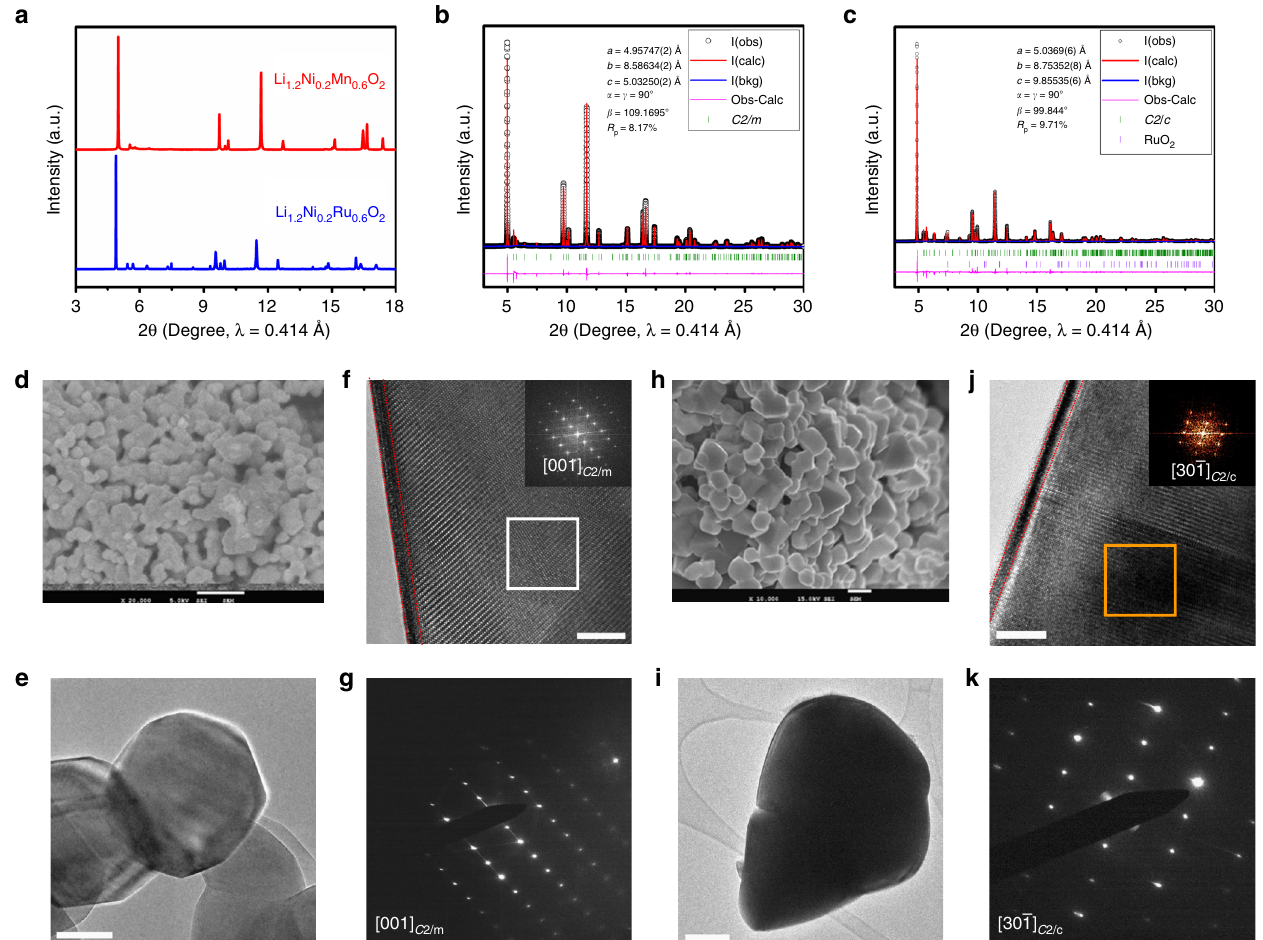
Fig. 1 Structural characterization of pristine Li 1.2 Ni 0.2 Mn 0.6 O 2 (LNMO) and Li 1.2 Ni 0.2 Ru 0.6 O 2 (LNRO). a Synchrotron XRD patterns, showing a similar crystal structure between these two compounds; XRD Rietveld re fi nement of b LNMO based on monoclinic C 2/ m and c LNRO based on monoclinic C 2/ c ; d scanning electron microscopy (SEM) image of LNMO, the scale bar is 1 μ m; e , f high-resolution transmission electron microscopy (HRTEM) images of LNMO with fast Fourier transform (FTT) of the selected area, the scale bar in (e) and (f) is 50 and 5 nm, respectively; g electron diffraction (ED) pattern for LNMO; h SEM image of LNRO, the scale bar is 1 μ m; i , j HRTEM images of LNRO with FTT of the selected area, the scale bar in ( i ) and ( j ) is 100 and 2 nm, respectively; k ED pattern for